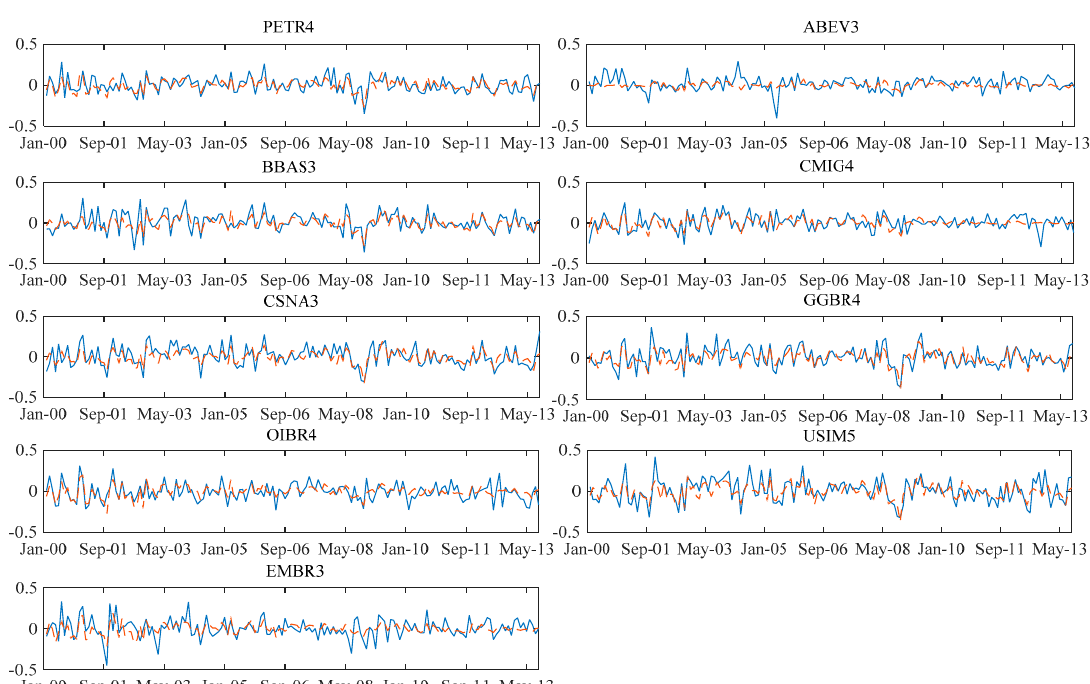
Figure A3. Actual (blue line) versus predicted (red line): Significant A&F models.